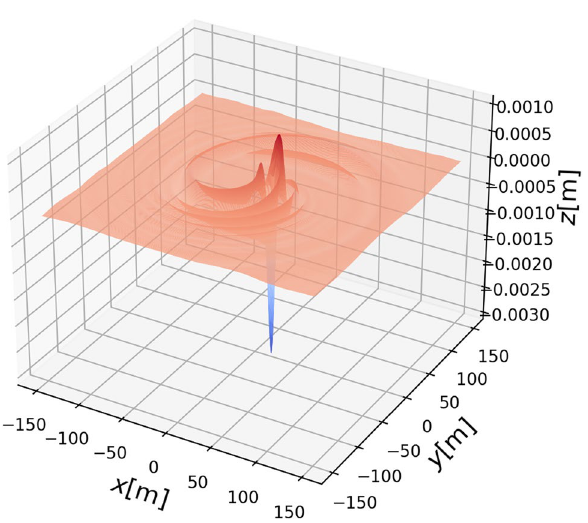
38.7 s. Note that a quasi-steady wave pattern =